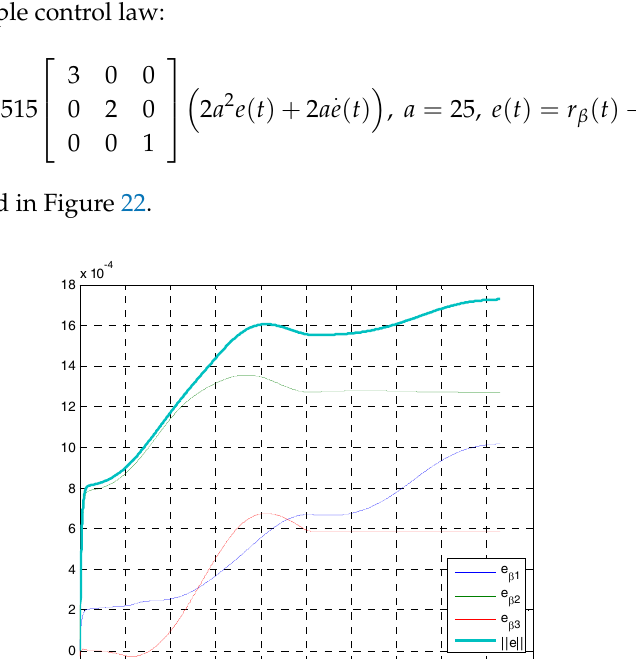
Figure 21. Time histories of the errors with the controller (68).